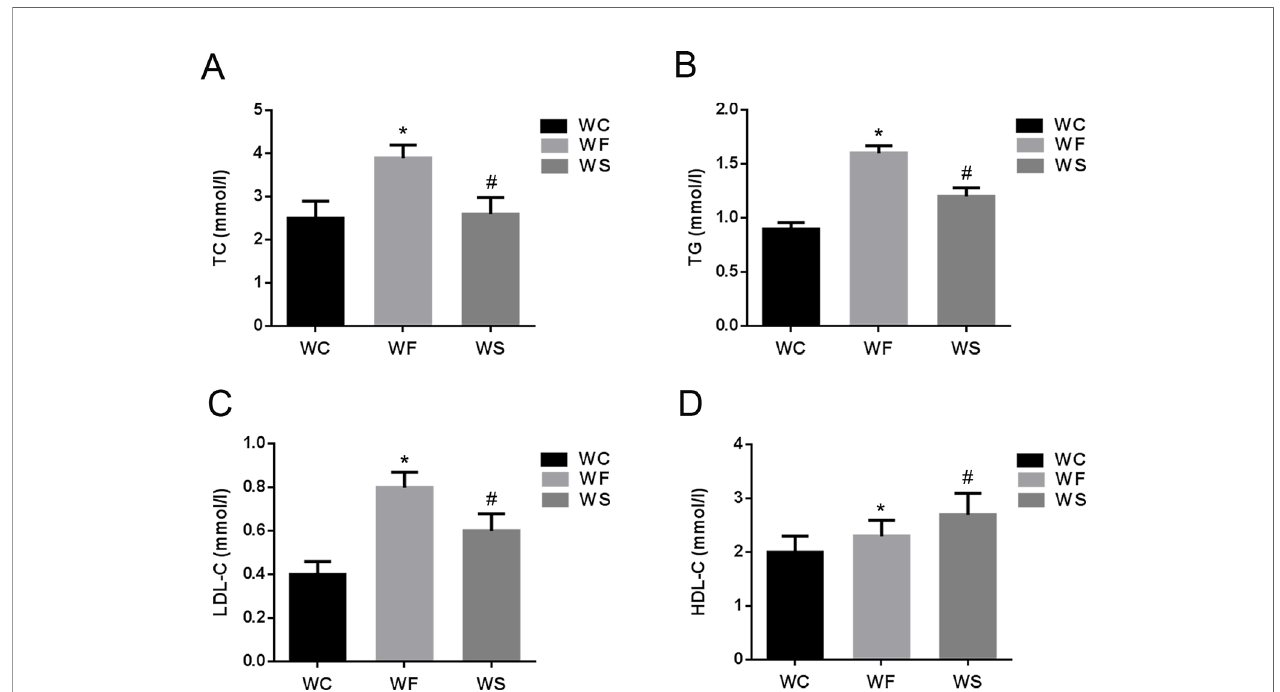
FIGURE 2 | The comparison of TC (A) , TG (B) , LDL-C (C) , and HDL-C (D) in mice of groups WC, WF, and WS. *P < 0.05 vs WC, # P < 0.05 vs WF. WC, normal diet; WF, high fat diet; WS, high fat diet +